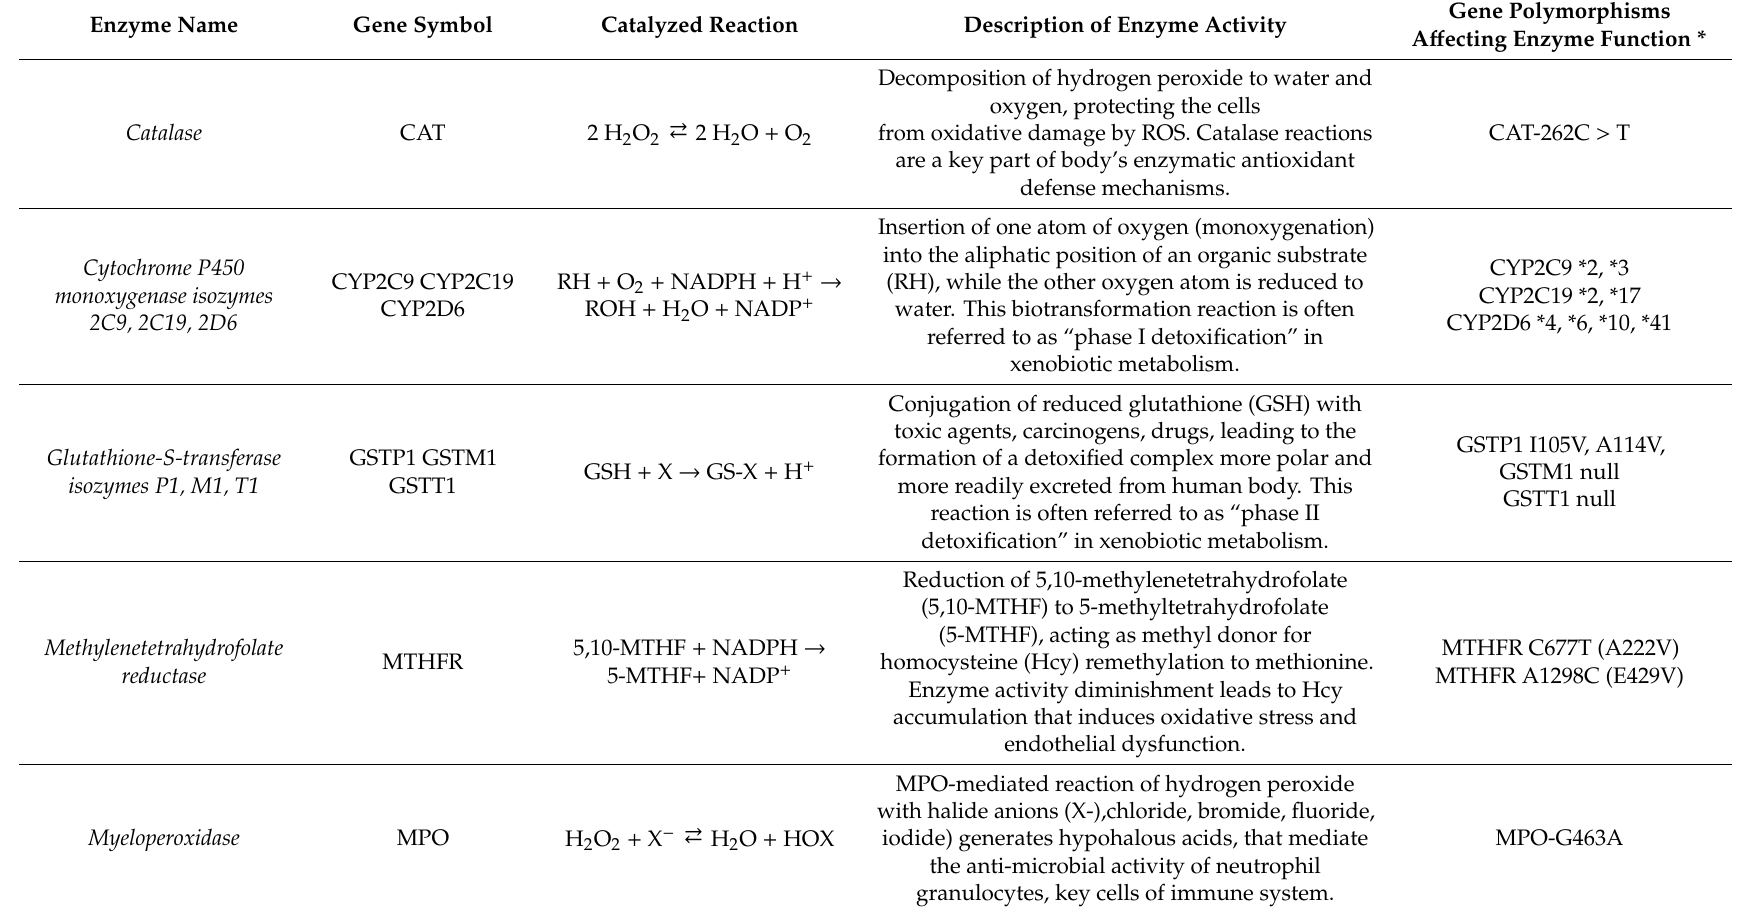
Table 5. Metabolic role of enzymes for which the occurrence of gene variants, a ff ecting enzyme activity, has been observed in MCS patients.